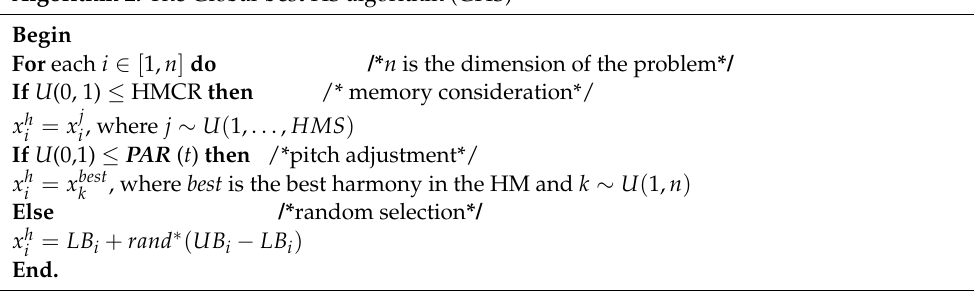
Algorithm 2. The Global-best HS algorithm